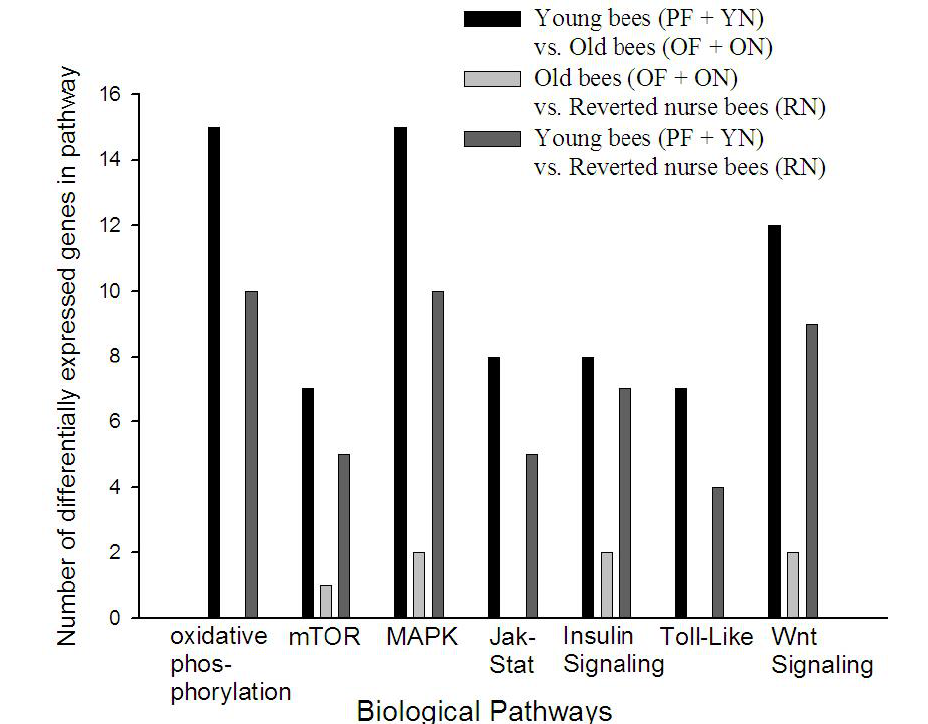
Figure 5. Comparison of signaling pathways. The KEGG database revealed pathways and the number of differentially expressed (FDR < 0.05) transcripts. The x-axis represents the number of genes differentially expressed for the biological pathway represented on the